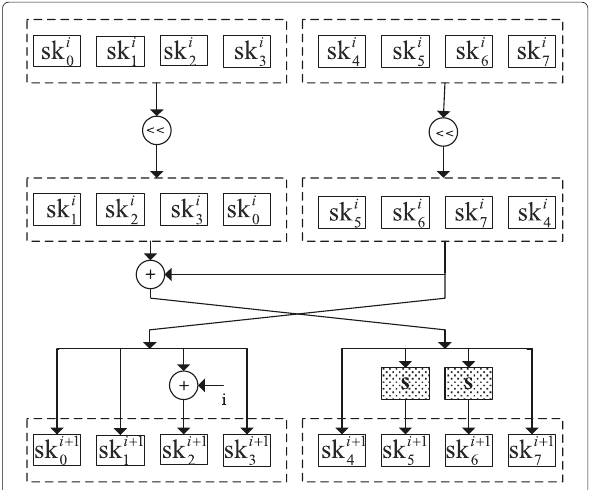
Fig. 2 The key scheduling of 64-bit key length of